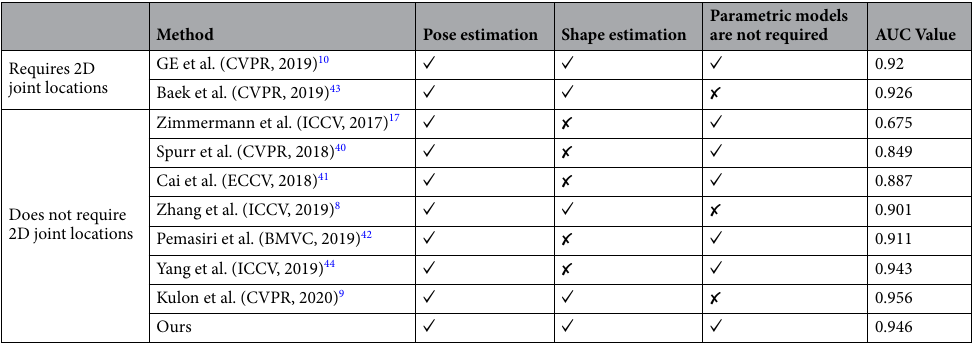
Table 3. Area under curve values for RHD dataset, which are related to Fig. 5a.